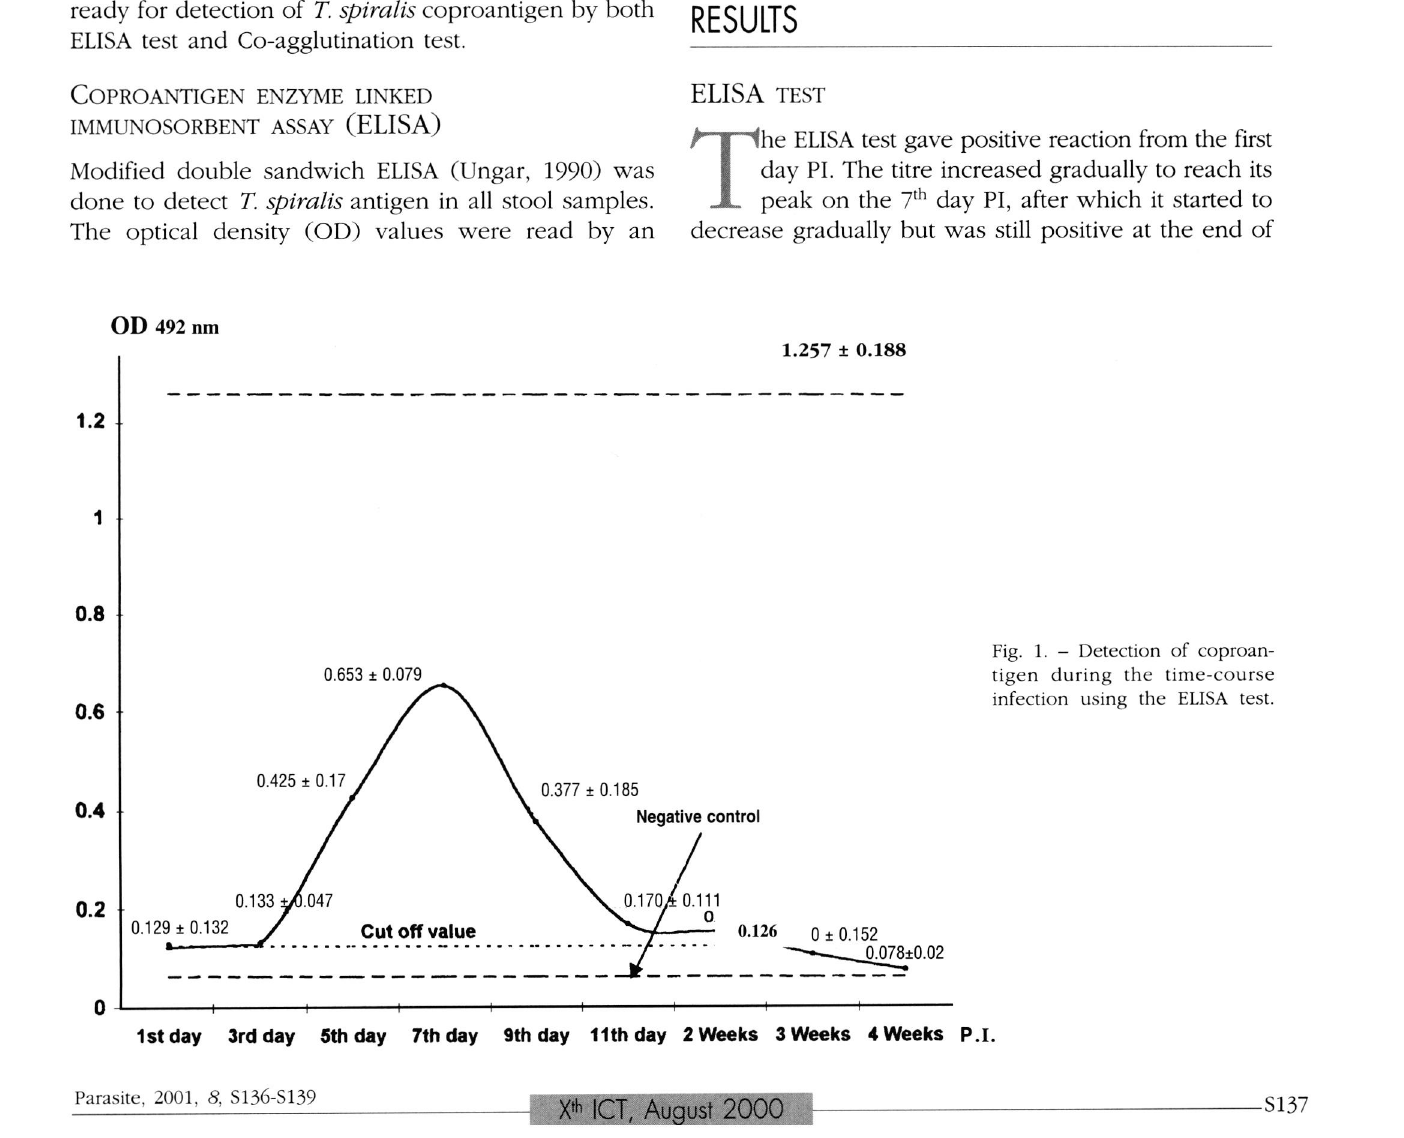
Fig. 1. - Detection of coproan tigen during the time-course infection using the ELISA